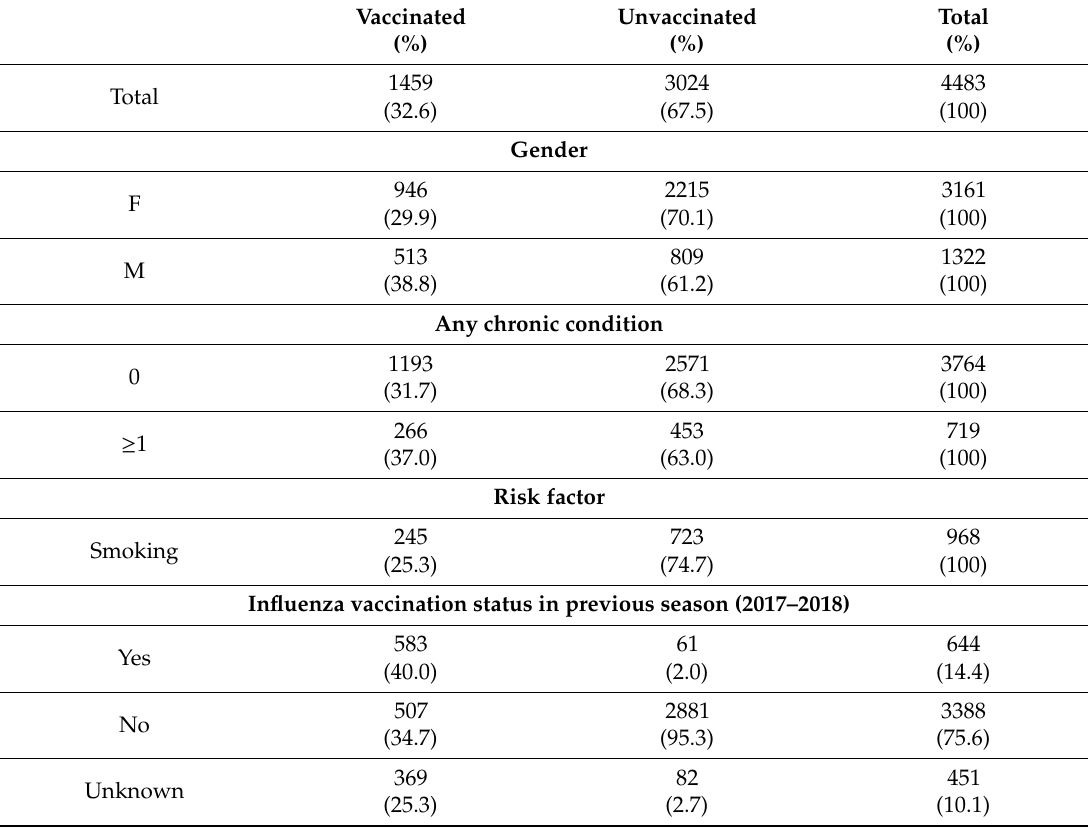
Table 2. Characteristics of vaccinated and unvaccinated subjects in 2018–2019